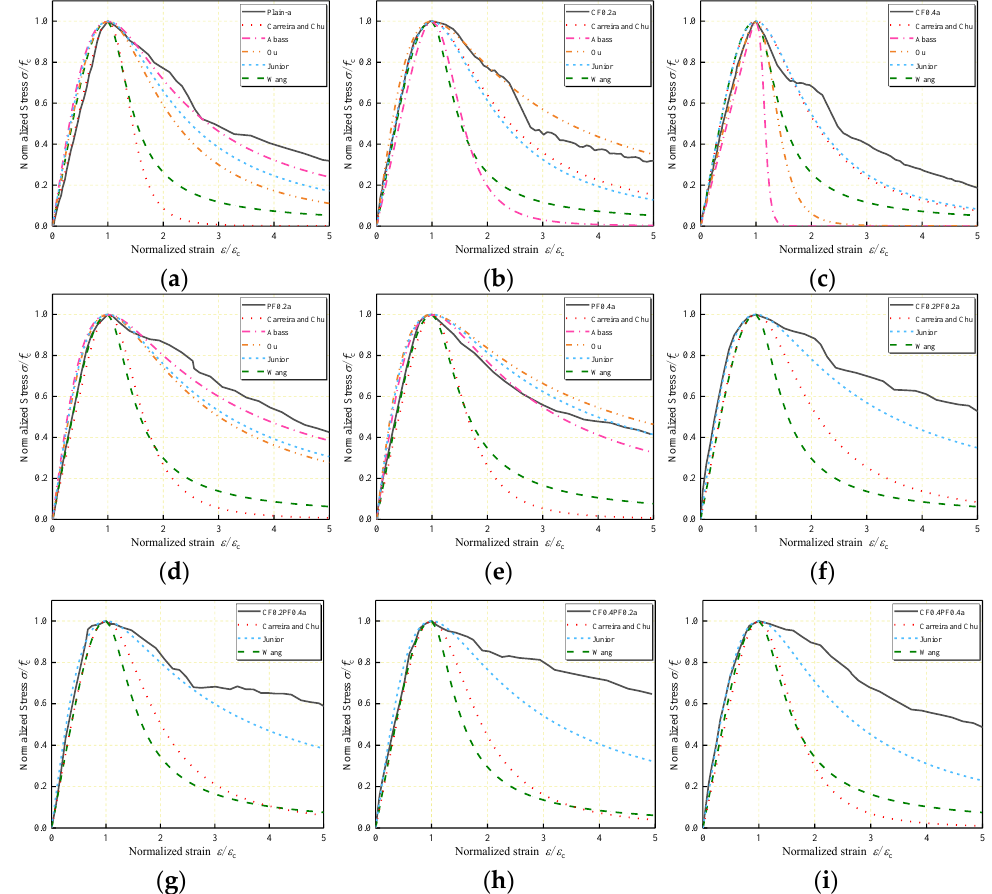
Figure 9. Application of existing stress – strain models to the data of: ( a ) Plain – a; ( b ) CF0.2a; ( c ) CF0.4a;